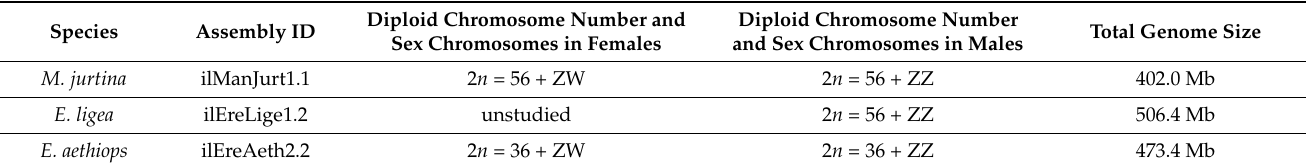
Table 1. GenBank IDs, karyotypes, sex chromosome systems and genome sizes in the studied species of the subfamily Satyrinae (according to GenBank data and published data